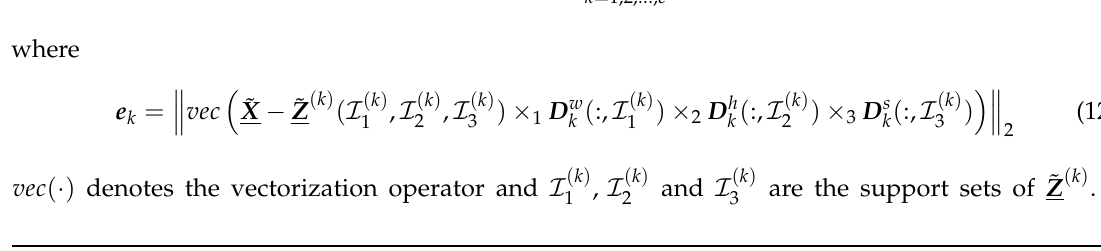
Algorithm 1: Class-Dependent Block Sparse Representation